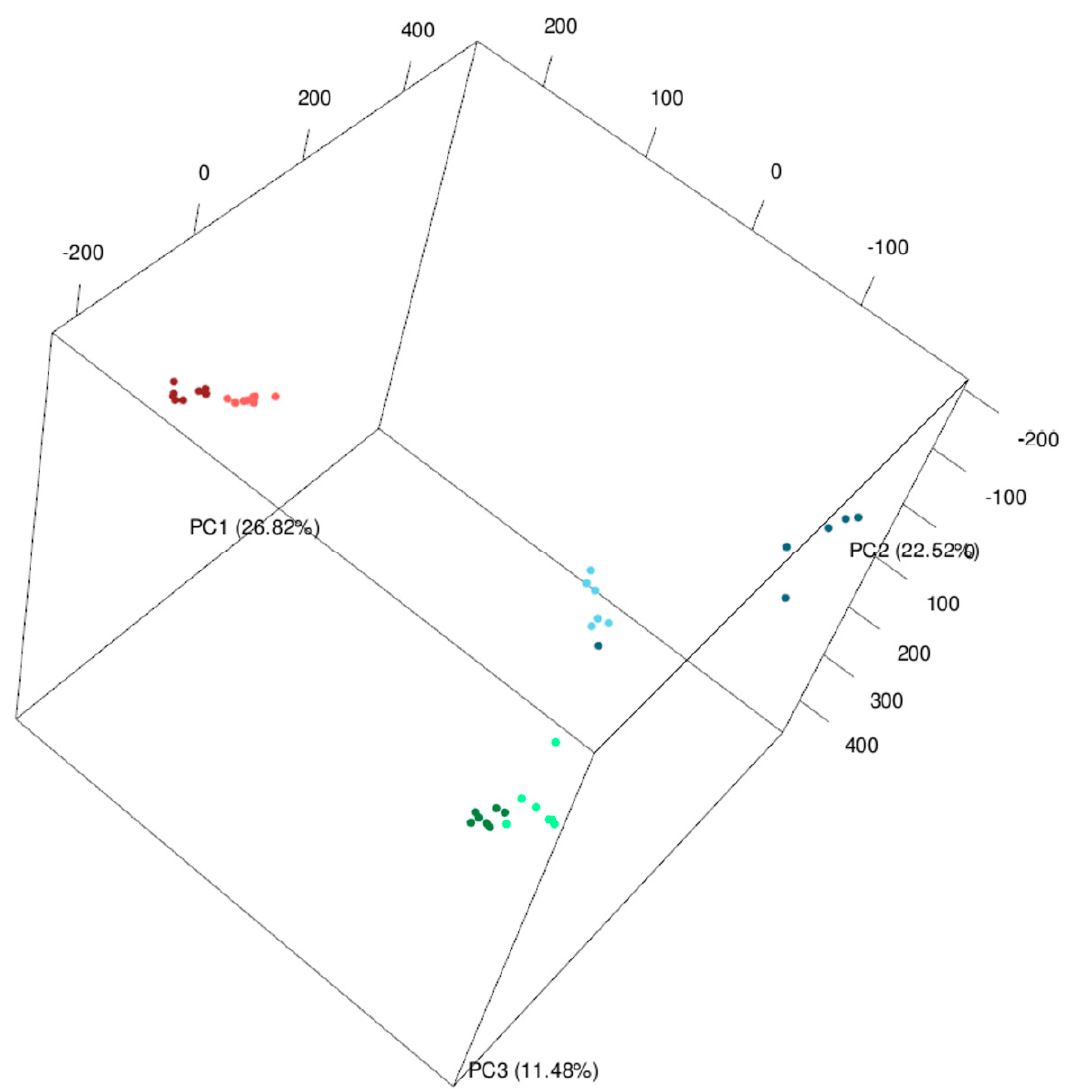
Figure 1. Three-dimensional principal component analysis (PCA) plot of global metabolite profiles in leaves (green), spikes (blue) and roots (red) of Brachypodium Bd21 (light colours) and Bd3-1 (dark colours) lines.